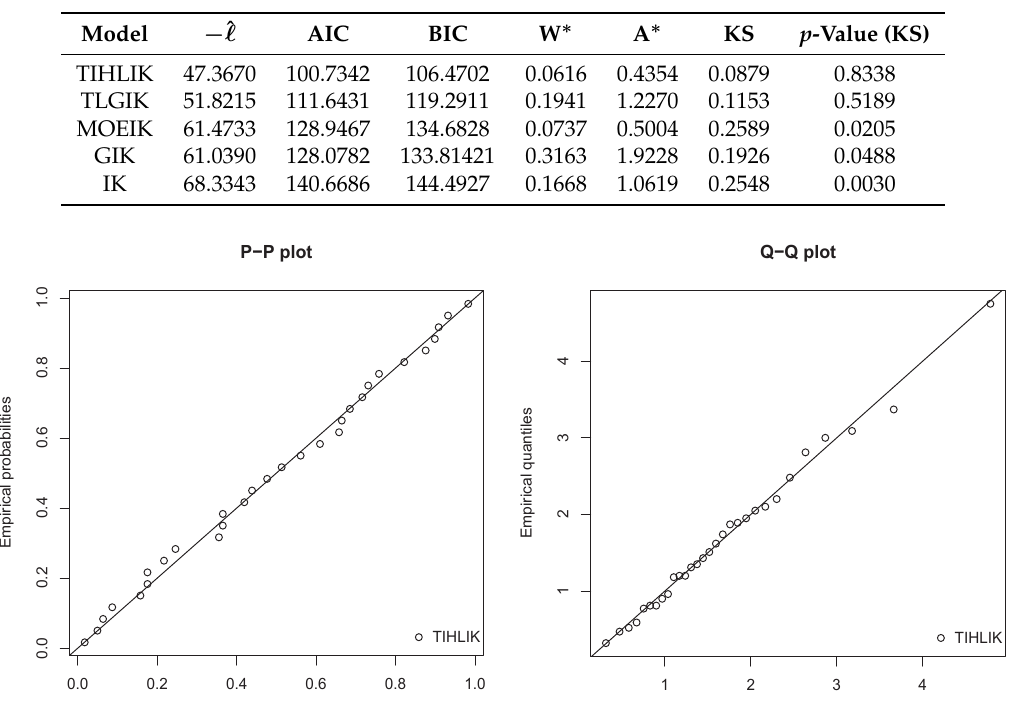
Table 10. The − ˆ (cid:96) , AIC , BIC, W ∗ , A ∗ , KS, and p -value values for data set 2.